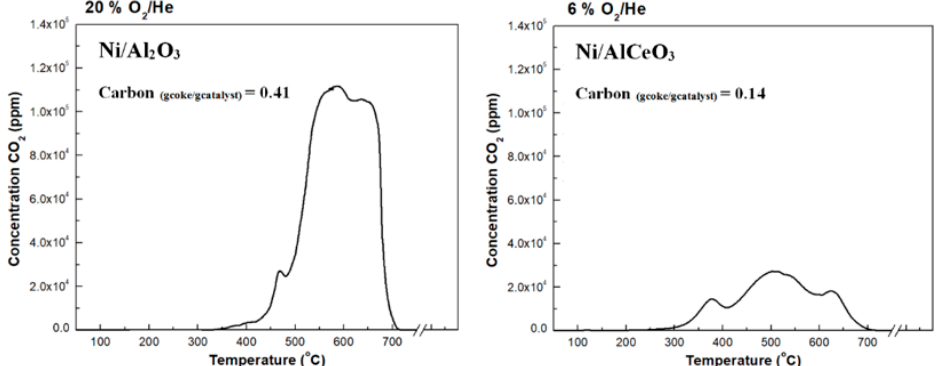
Figure 10. Temperature Programmed Oxidation (TPO) profiles and total amount of deposited carbon obtained for the spent Ni/Al 2 O 3 and Ni/AlCeO 3 catalytic samples (samples tested under experimental protocol #2).